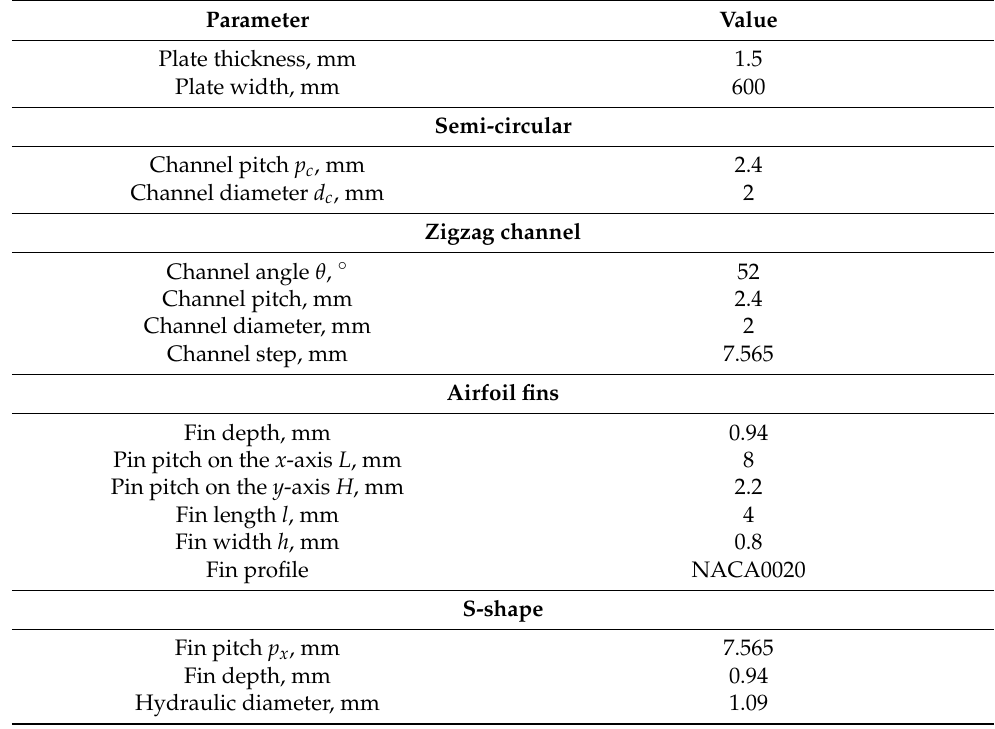
Table 2. Channels geometry parameters.